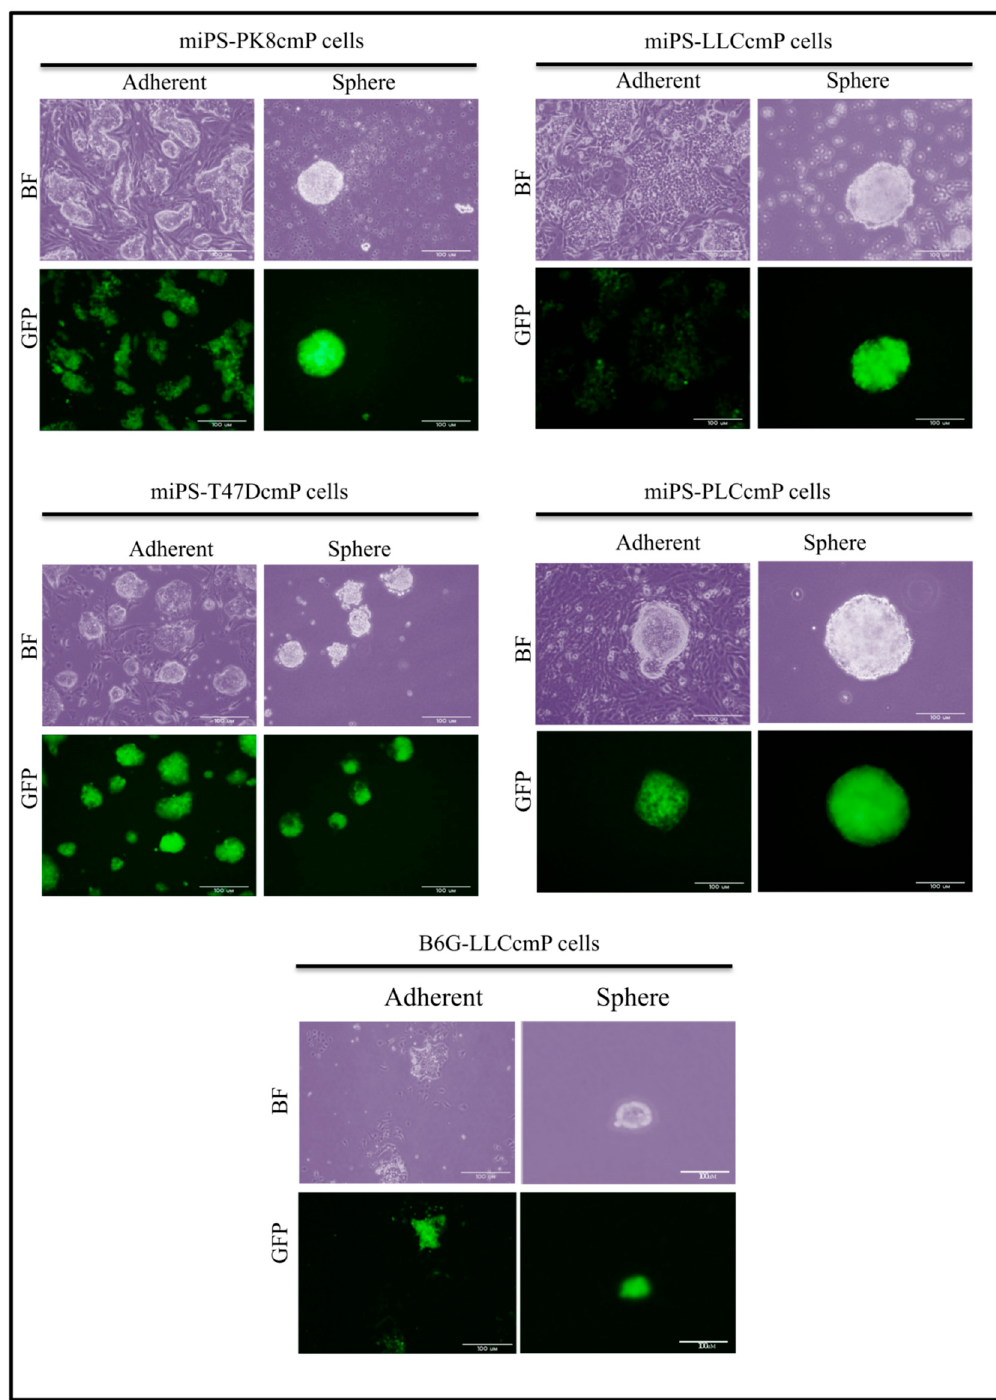
Figure 7. Representative images of di ff erentiation and self-renewal potential of primary culture cells derived from malignant tumor.